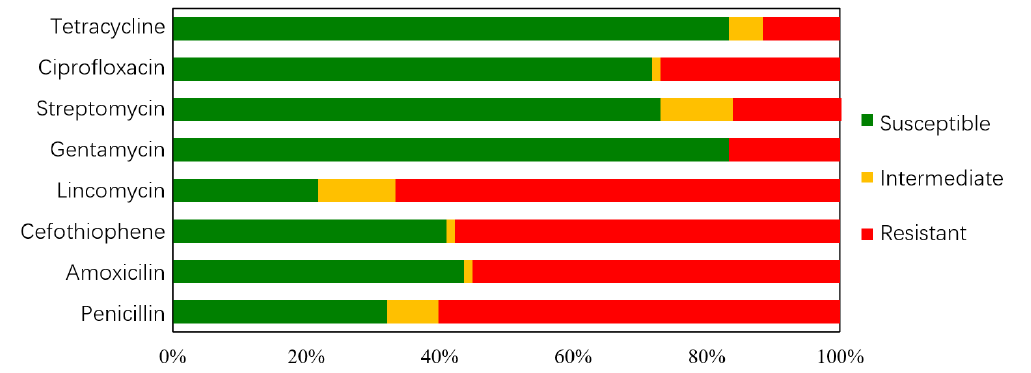
Figure 2. Phenotypic drug-resistance proportions of E. coli. All the 78 isolates of E. coli were analyzed with 8 antimicrobial agents. The bars in green, yellow, and red indicate the antimicrobial’s susceptibility with susceptible, intermediate, and resistant, respectively.